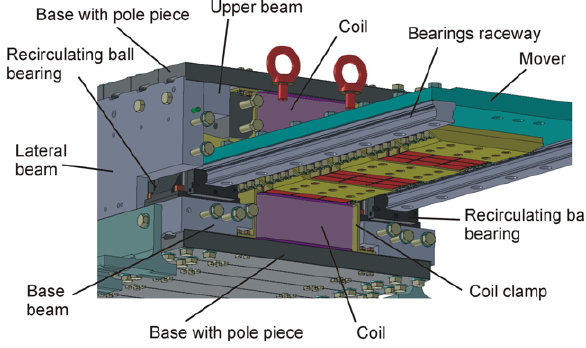
Figure 6: Internal structure of the electromagnetic